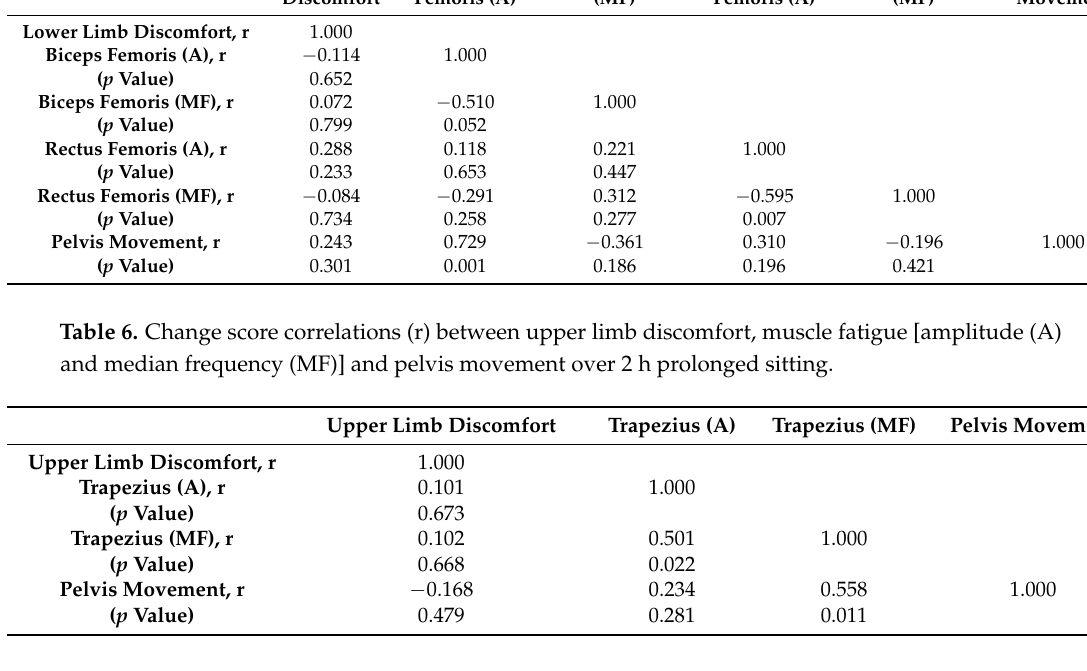
Table 7. Change score correlations (rho) between total body discomfort, creative problem solving, sustained attention and mental state over 2 h prolonged